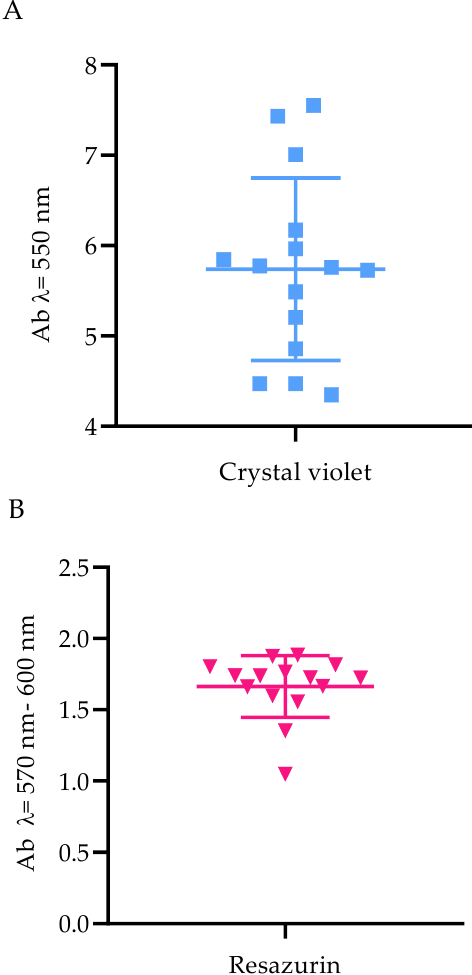
Figure 1. The ability of Pseudomonas aeruginosa clinical (PA 1–7, PA 13–19) and the reference (ATCC 15442) strains to form biofilm. ( A ) Biofilm biomass level assessed with the crystal violet method. ( B ) Metabolic activity of biofilm-forming cells, determined with resazurin staining. Ab, absorbance. The average and standard deviations are marked.